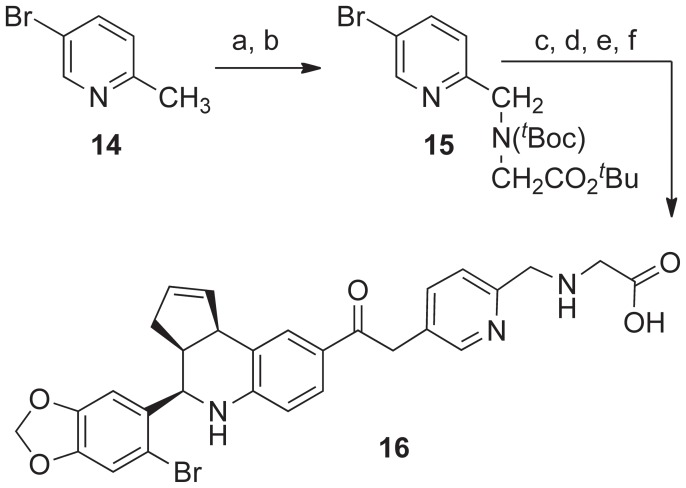
Synthesis of pyridin-2-yl-methylaminoethanoic acid ligand 16.Reagents and conditions: a) NBS (1eq), AIBN (20 mol%), CCl4, 65°C, 20 h, 43%; b) tert-butoxycarbonylamino-acetic acid tert-butyl ester (1 eq), NaH (1 eq), DMF, rt, 2 h, 9 83%; c) TMS-acetylene, PdCl2(PPh3)2 (10 mol%), CuI(8 mol%), Hunigs base, NMP, 80°C, 2 h, 98%; d) AgOTf (20 mol%), CH2Cl2/MeOH/H2O (7∶4∶1), rt, 20 h, 90%; e) 1 (0.85 eq), PdCl2(PPh3)2 (10 mol%), CuI( 10 mol%), Et3N, NMP, rt, 6 h, 90%; f) TFA/DCM (0.8∶1.0), 45 min, 16, 70%.